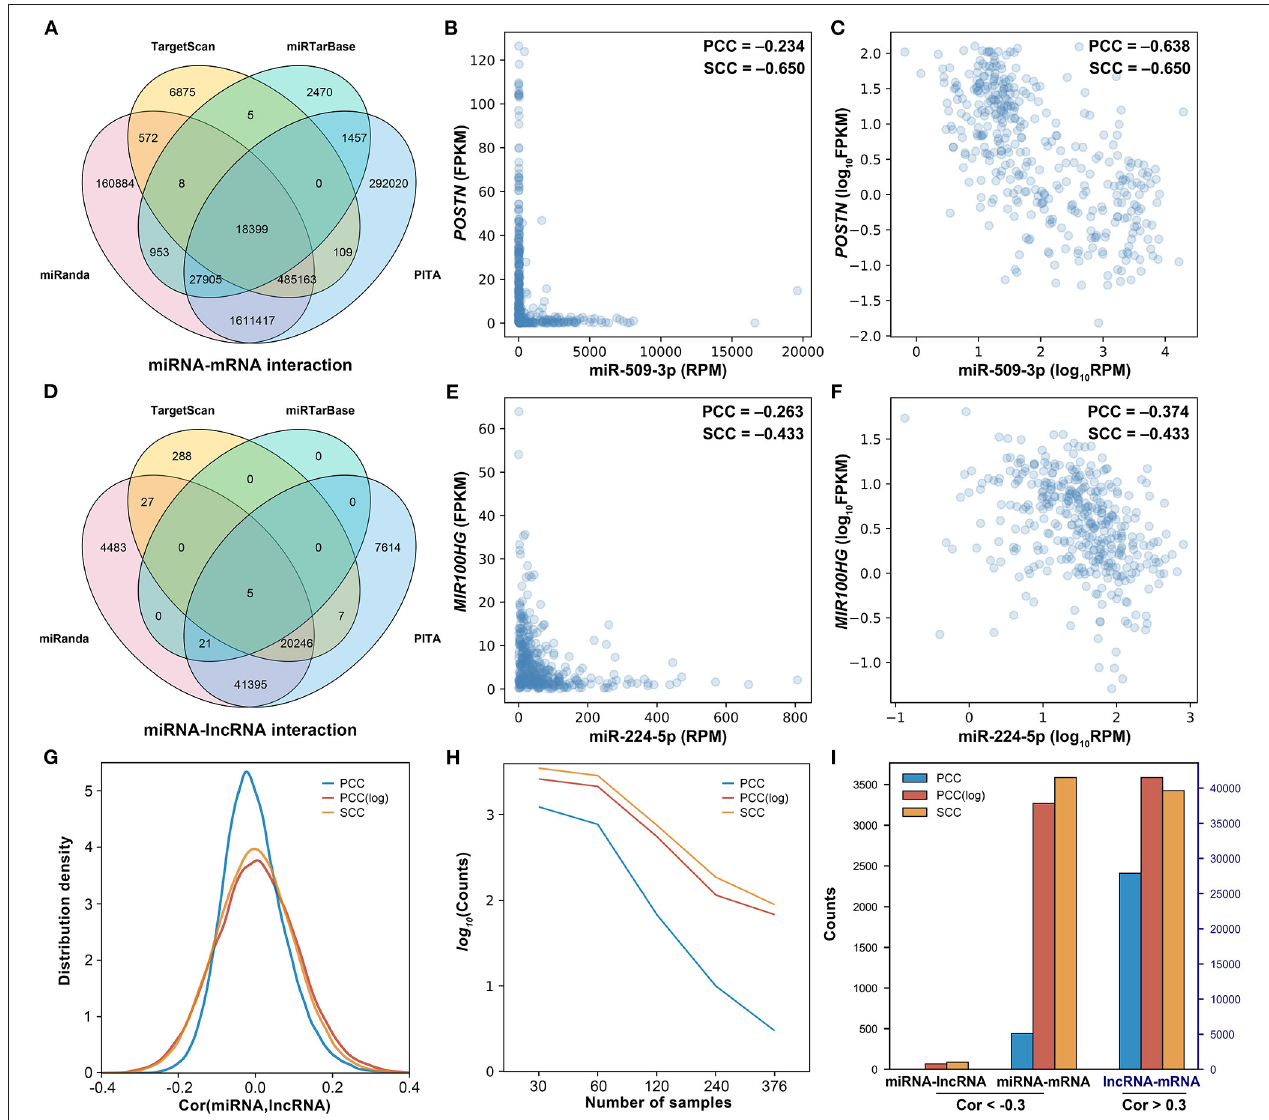
FIGURE 2 | Investigation of the correlation between miRNA and the target. (A) The Venn diagram of miRNA–mRNA pairs. (B) The scatter plot of miR-509-3p and POSTN . (C) The scatter plot of miR-509-3p and POSTN after logarithmic transformation. (D) The Venn diagram of miRNA–lncRNA pairs. (E) The scatter plot of miR-224-5p and MIR100HG . (F) The scatter plot of miR-224-5p and MIR100HG after logarithmic transformation. (H) The density distribution of the correlation between miRNA and lncRNA. PCC, Pearson correlation; PCC(log), Pearson correlation after logarithmic transformation; SCC, Spearman correlation. (G) The influence of the sample size on the identification of the negatively correlated miRNA–lncRNA pairs. Negative correlation: cor(miRNA,lncRNA) < − 0.3, p -value < 0.05. (I) The counts of correlated miRNA–lncRNA, miRNA–mRNA, and lncRNA–mRNA calculated on 376 ovarian cancer